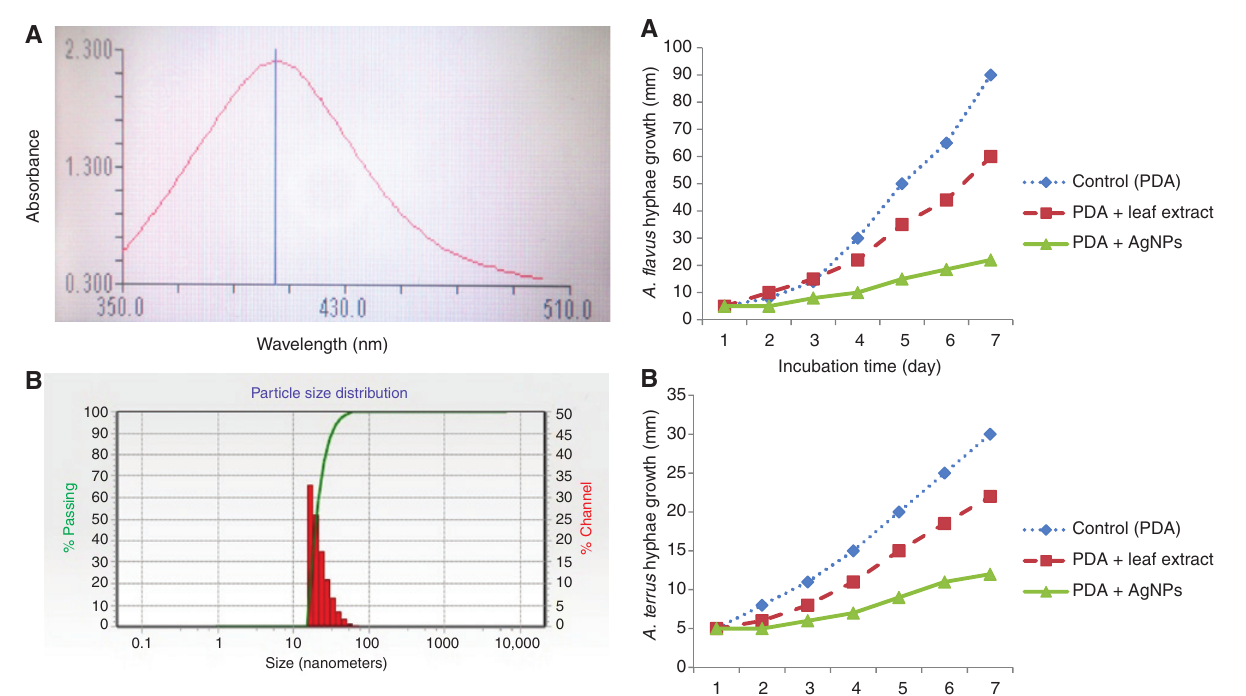
Figure 6: SPR spectrum (A) and particle size distribution (B) of the synthesized AgNPs at obtained optimum synthesis conditions.